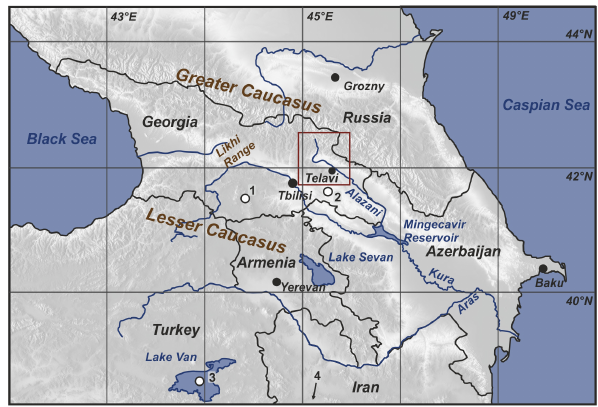
Figure 1. Overview of the Caucasus region. The red rectangle marks the study area in the upper Alazani valley. Regional pollen records that are used for comparison in this study are marked with a white dot: 1 = Lake Paravani (Messager et al., 2013), 2 = Sagarejo sediment section (Gogichaishvili, 1984), 3 = Lake Van (Litt et al., 2009), 4 = Lake Urmia (Bottema,